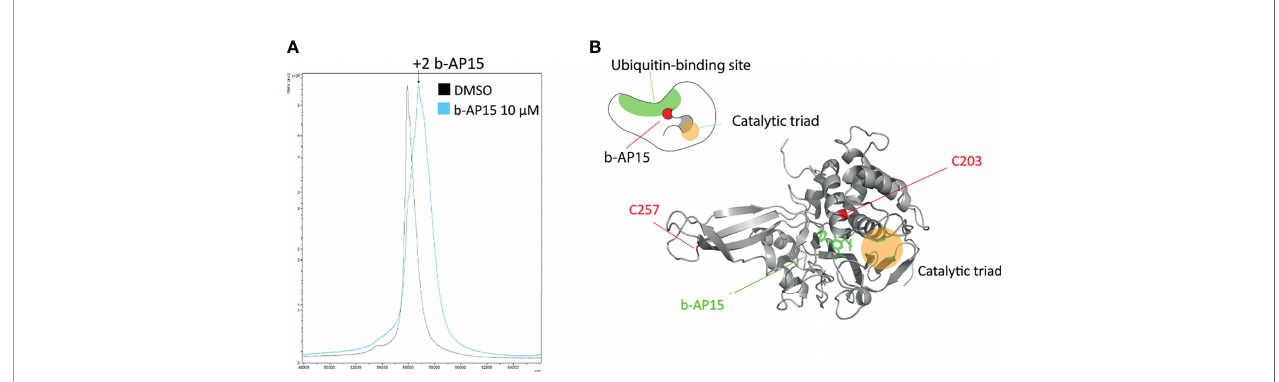
FIGURE 5 | b-AP15 binds USP14. Recombinant USP14 was exposed to 10µM b-AP15 or DMSO for 1 hour and subjected to mass spectrometry to identify binding sites. (A) MALDI-TOF mass spectrum Peak from b-AP15-treated sample shows a mass shift of roughly 810 Da corresponding to 2 molecules of b-AP15. LC-MS/MS shows b-AP15 modi fi cations on Cys203 and Cys257 ( Supplementary Figure 2) (B) Docking study of b-AP15 on crystal structure of USP14 (2ayo) reveals that b-AP15 docks on between the ubiquitin binding surface and the crevice that leads to the catalytic triad. Top drawing is a representation of b-AP15- bound USP14.